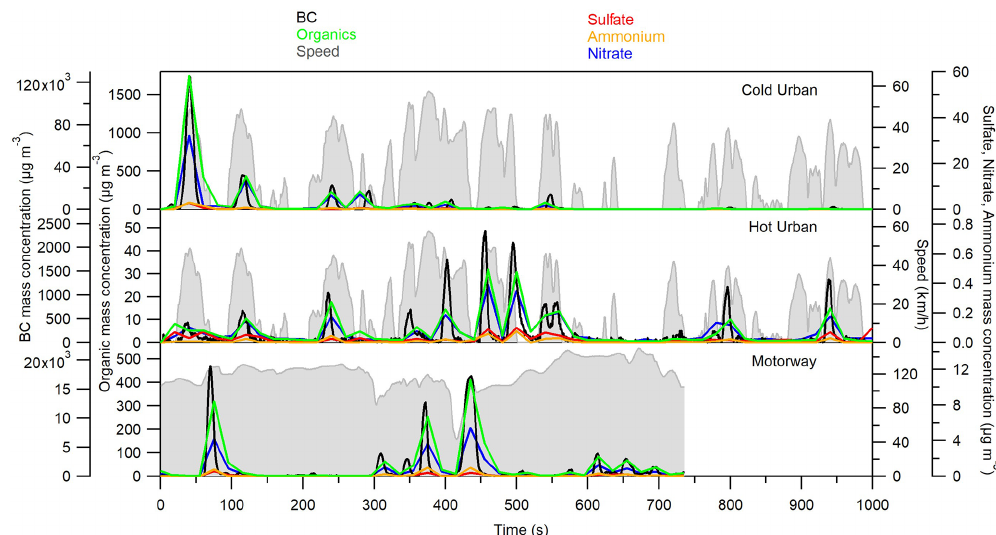
Figure 1. BC, organics, sulfate, nitrate, and ammonium time profiles during a cold urban, a hot urban, and a motorway Artemis cycle for the GDI3 vehicle.